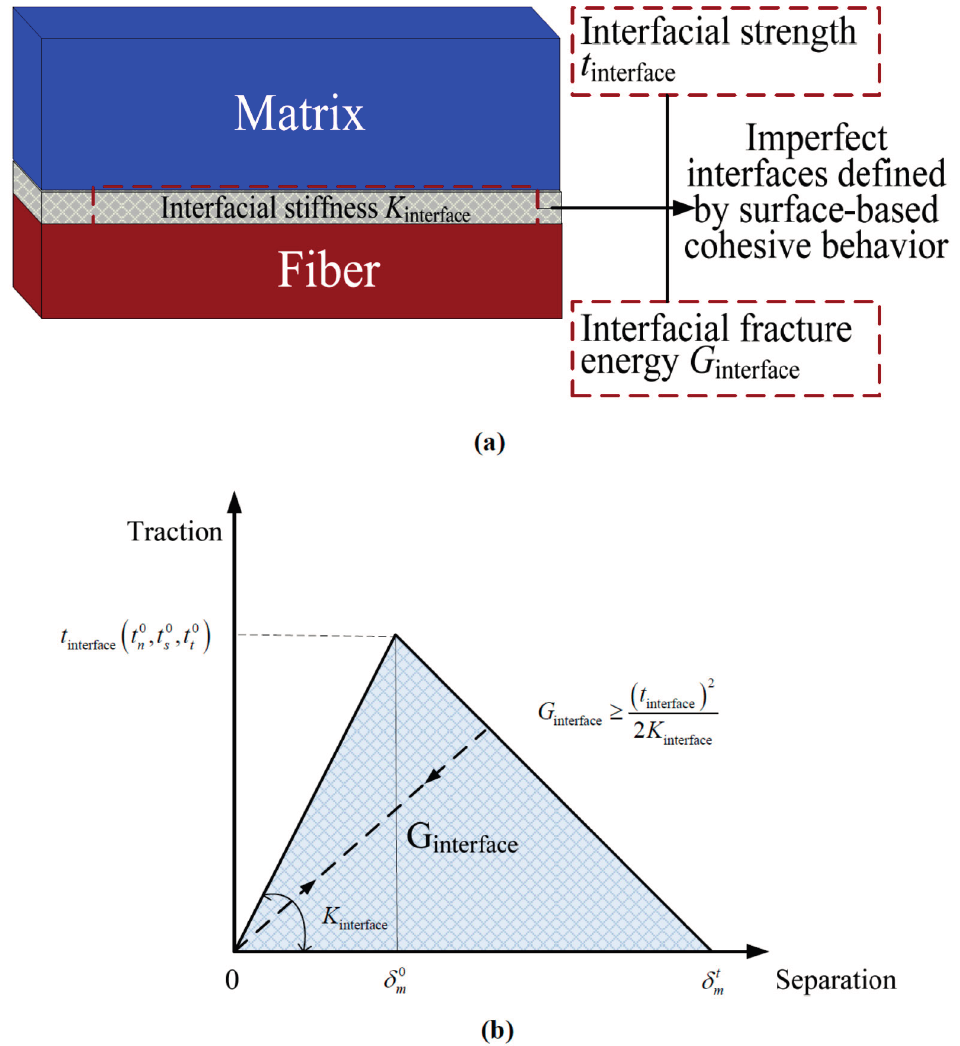
Figure 14. ( a ) Imperfect interface defined by surface-based cohesive behavior; and ( b ) typical traction-separation